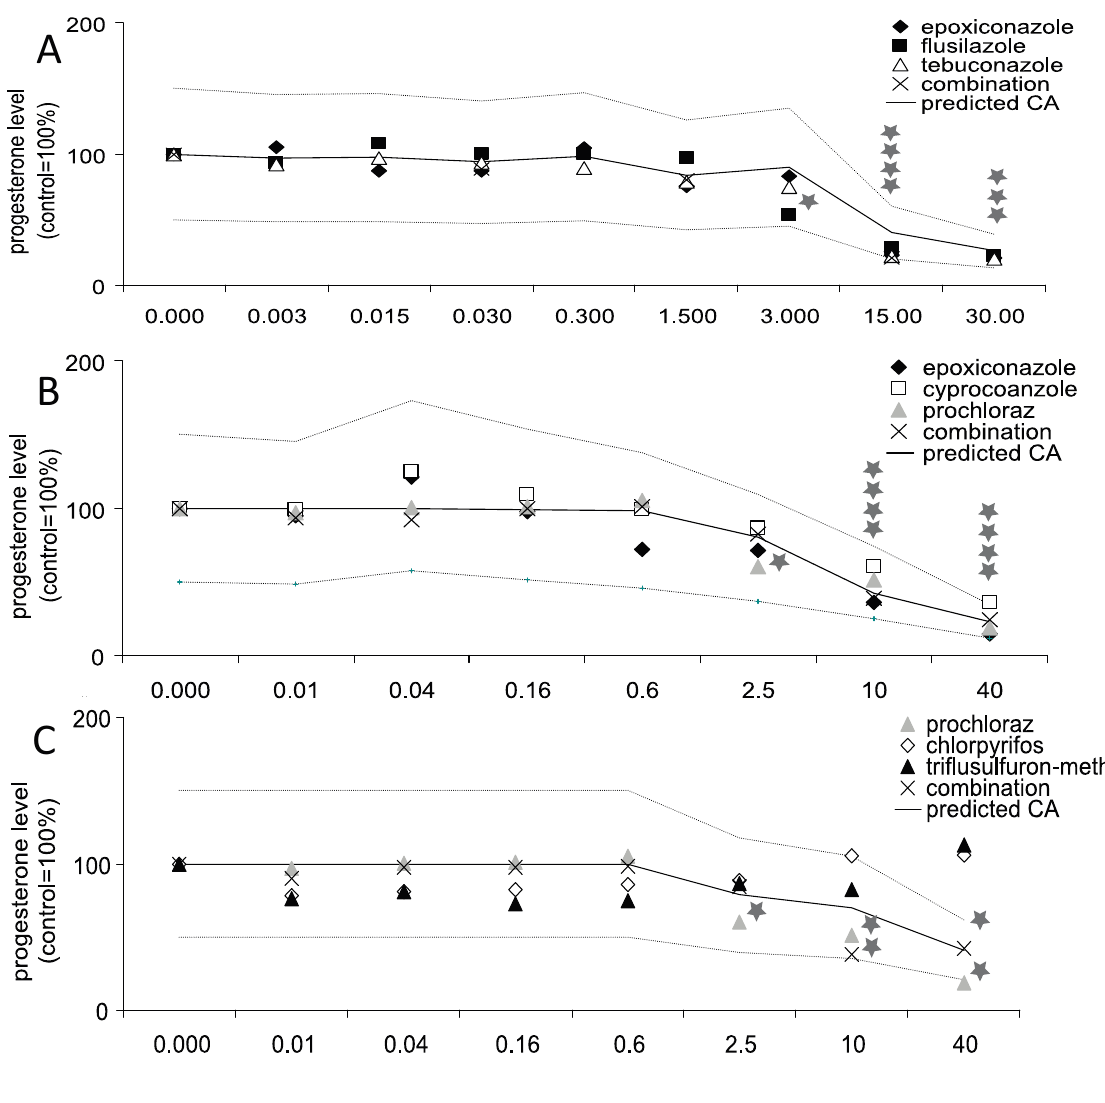
Figure 1. Influence of active substances alone or in combination on progesterone production in Jeg-3 cells. Jeg-3 cells were grown in 6-well cell culture plates for 24 h. Thereafter, the cells were incubated with the substances in concentrations as indicated for 48 h individually and in combination: ( A ) flusilazole, epoxiconazole and tebuconazole, ( B ) epoxiconazole, cyproconazole and prochloraz, ( C ) prochloraz, chlorpyrifos and triflusulfuron-methyl. Finally, the supernatant was collected and progesterone concentration measured by ELISA as indicated by the manufacturers’ protocol. The data represent the mean ± SD for three independent experiments. Concentration values given for combination treatments reflect total concentrations of all three components. Predicted additivity (CA) indicates the calculated combination effect when additivity is assumed. The upper and the lower lines around the predicted CA indicate the MDR (model deviation ratio) based on the predicted CA. Concentrations are given in µM. For graphical clarity error bars were abandoned. The mean standard deviation was about 15%, with the exemption of one combination group (B), where the mean standard deviation turned out to be 30%. Concentration values given for combination treatments reflect total concentrations for all three components. * Indicates significance with p ≤